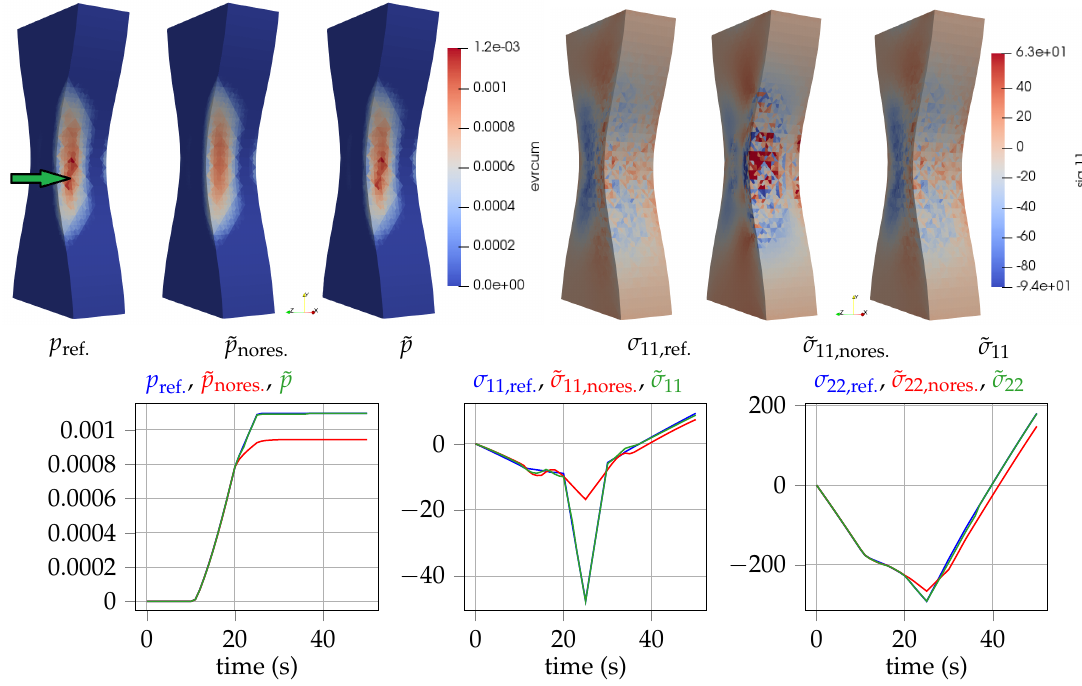
Figure 9. Offline variability: computation 1 and computation 2; online variability: new. ( top ) Representation of dual fields for the reference HF prediction of the online variability, ROM without enrichment, and ROM with enrichment (( left ) p at t = 50 s and ( right ) σ 11 at t = 25 s). ( bottom ) Comparison of p , σ 11 , and σ 22 at the point identified by the green arrow on the top-left picture.